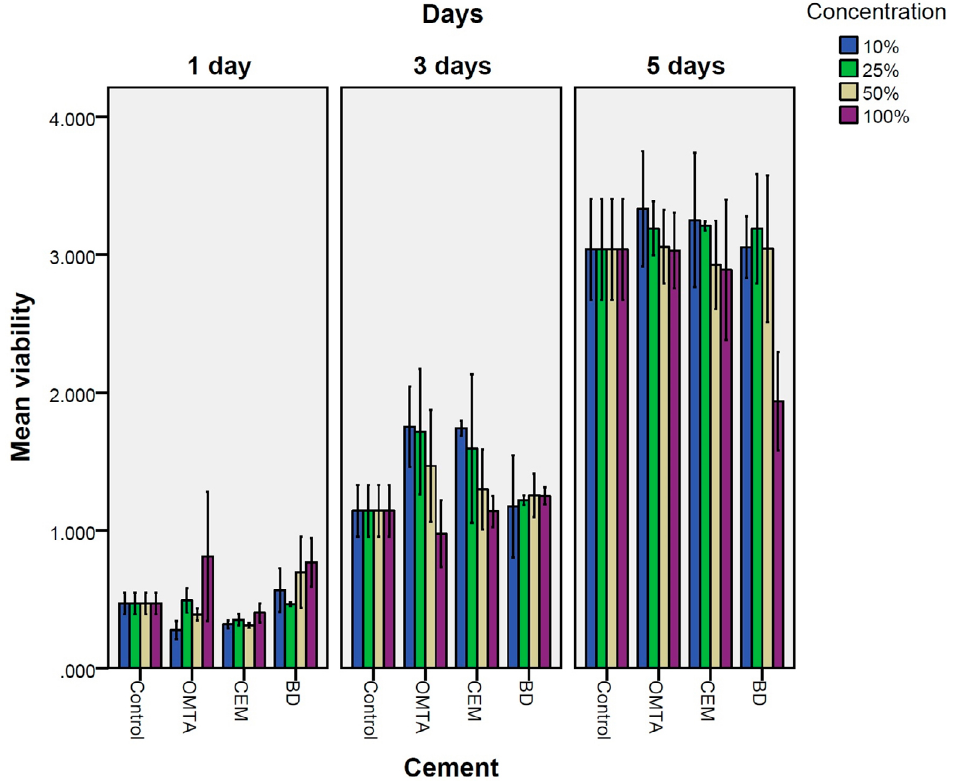
Figure 4- MTT assay. The one-way ANOVA test showed no significant difference in cell proliferation after exposure to 10, 25, 50, and 100% concentrations OMTA and CEM cement in days one, three and five. (p>0.05) Furthermore, no significant difference was observed in cell proliferation following exposure to different concentrations of BD in first and third days (p>0.05). The test demonstrated a significant decrease in cell proliferation following exposure to 100% concentration of BD (p=0.012). Three-way ANOVA test showed that cell proliferation of test materials in different concentrations presented no significant difference in days one and three compared to control group (p>0.05). On the other hand, cell proliferation was significantly lower than control on day five when exposed to 100% concentration of BD (p=0.016)